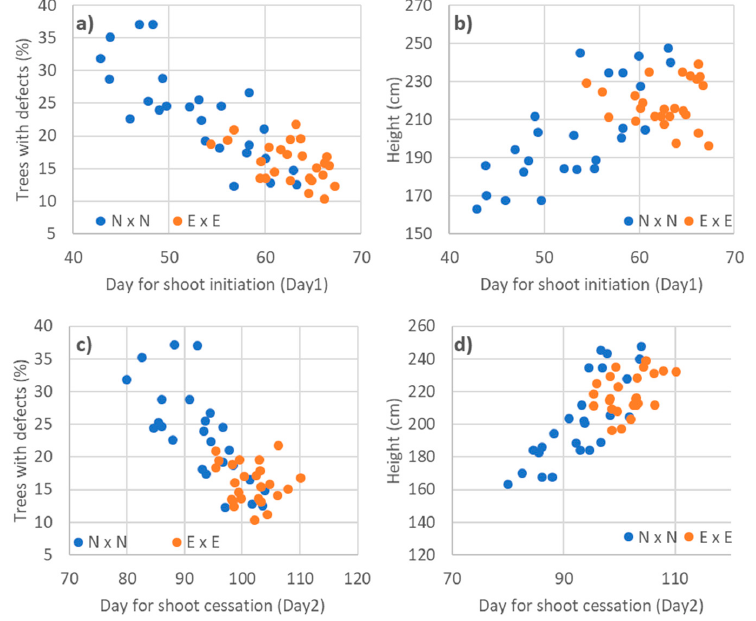
Figure 2. Plot of the relationships between the percentage of trees with stem defects ( a , c ) and tree height ( b , d ) with the day for shoot growth initiation (Day1) ( a , b ) and shoot growth cessation (Day2) ( c , d ) at the family-mean level (site 1–7). The material is grouped in N × N (blue) and E × E families (orange).